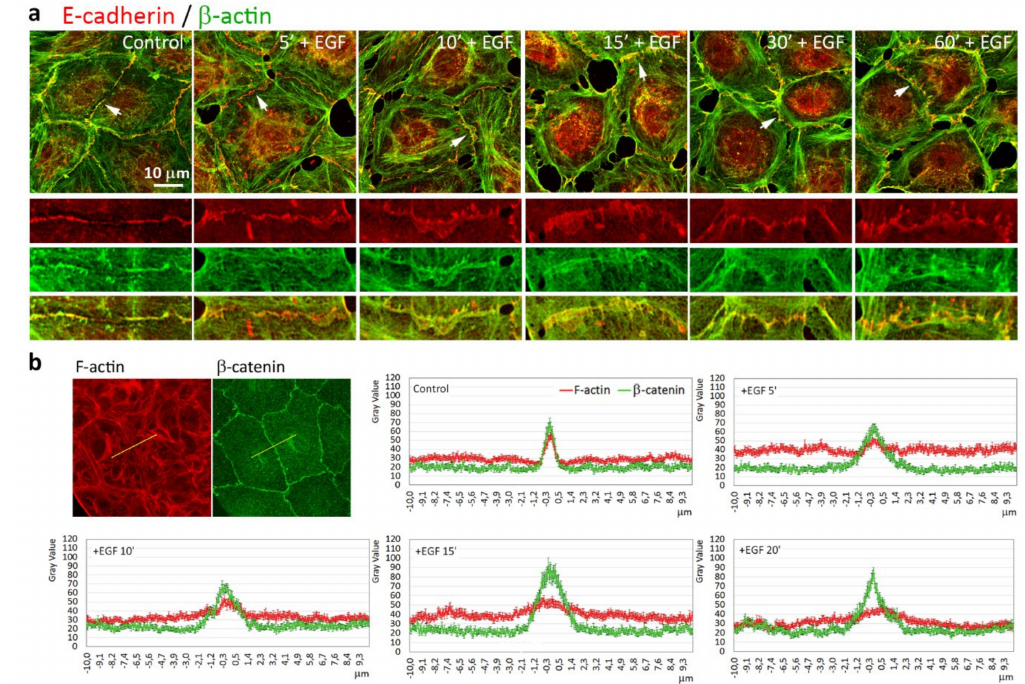
Figure 4. Rearrangement of E-cadherin-based AJs in parallel with reorganization of the actin cytoskeleton in IAR-20 cells treated with EGF. ( a ) Immunostaining of E-cadherin and β -actin. Top—red and green channels merged. The cell-cell boundaries enlarged below are indicated with arrows. Disorganization of AJs begins 5 min after addition of EGF, simultaneously with dissolution of the circumferential actin bundle and formation of lamellipodia. Beginning from 10–15 min after the addition of EGF, punctate AJs were connected with straight actin fibers appear. ( b ) Fluorescence intensity profiles of F-actin and β -catenin in the zones of cell-cell contacts. N = 30 for every